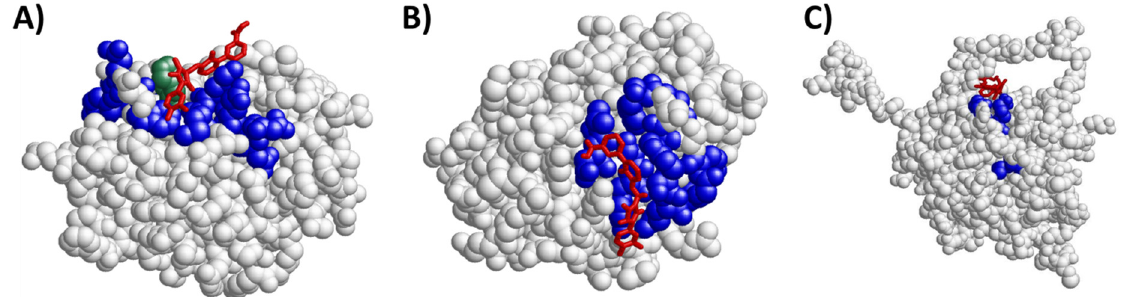
Figure 4. Structures from docking results for the predicted new targets (representing atoms as balls) and eltrombopag (structure represented as red sticks). ( A ) Bcl-2: amino acids highlighted in blue correspond to the BH4 domain and in green to histidine 20—Protein Data Bank identification code: 2XA0 [51]. ( B ) BCL2L1: amino acids highlighted in blue correspond to the BH4 domain—Protein Data Bank identification code: 1MAZ [53]. ( C ) BAX: amino acids highlighted in blue correspond to amino acids 60, 61, 64, and 70 from the BH3 domain—Protein Data Bank identification code: 2K7W [55]. Images were created with the software RasMol [57]. Bcl-2: B-cell lymphoma 2; BCL2L1: Bcl-2-like protein 1; BH3: Bcl-2 homology 3; BH4: Bcl-2 homology 4.